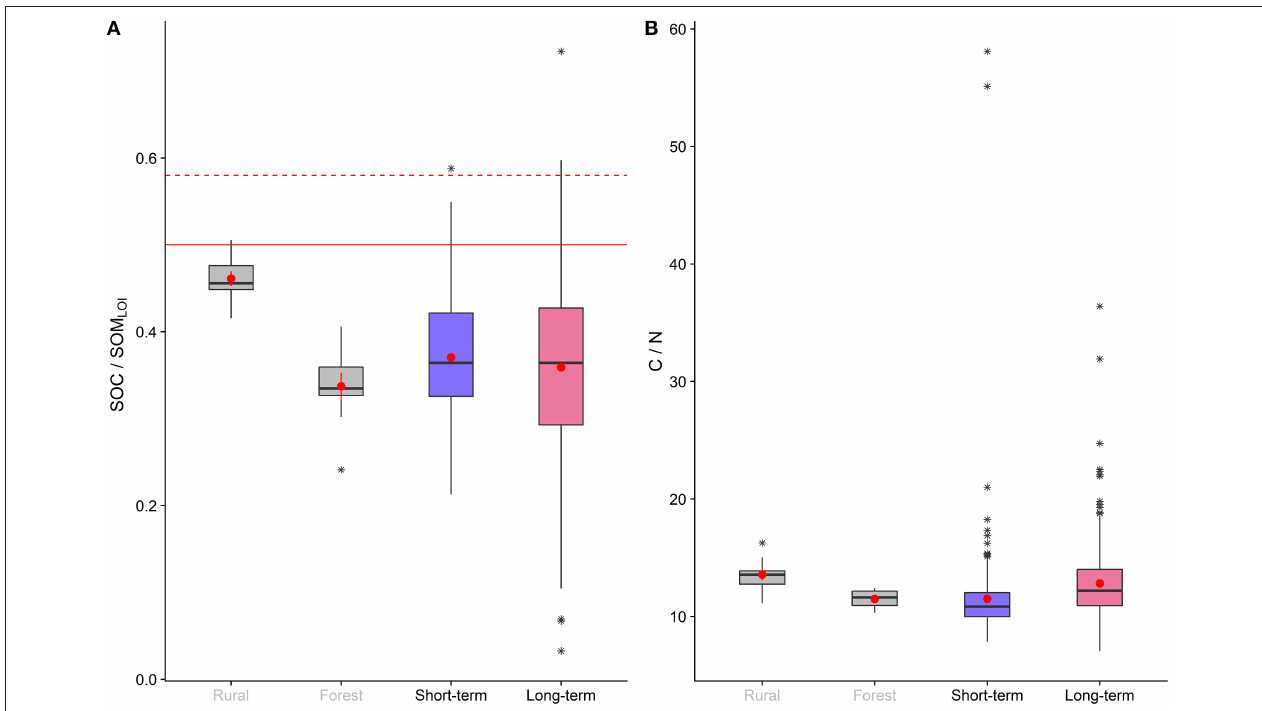
FIGURE 9 | Boxplots comparing rural, forest and urban soils with respect to their (A) SOC/SOM LOI ratios, and (B) C/N ratios. Arithmetic means (red points), standard errors (red whiskers), medians (bars), ranges (whiskers), and outliers (asterisks) are shown. In (A) , the thick red line represents the ratio of 0.5, and the dash red line represents the ratio of 0.58, which are both commonly used in literature for SOC/SOM